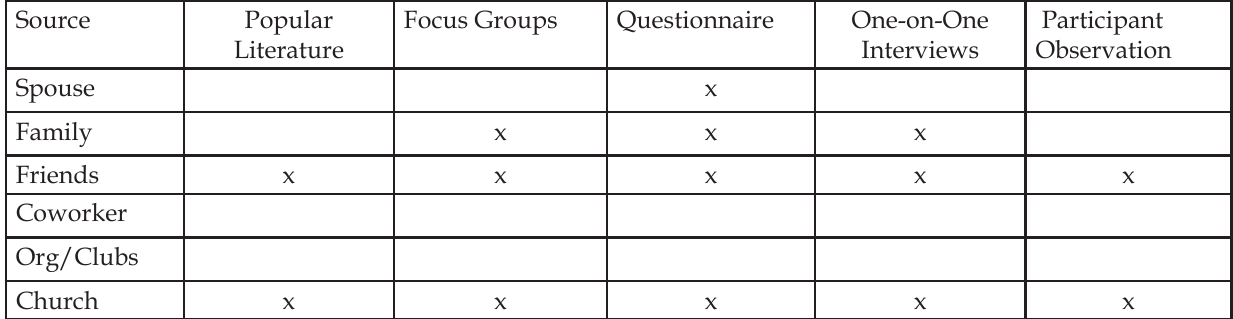
Table IV. Sources of Spiritual